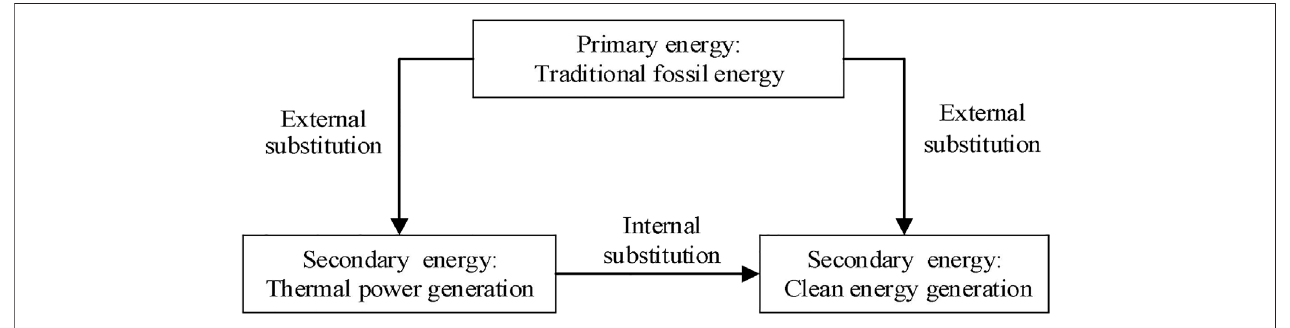
FIGURE 1 | Boundary de fi nition of internal and external